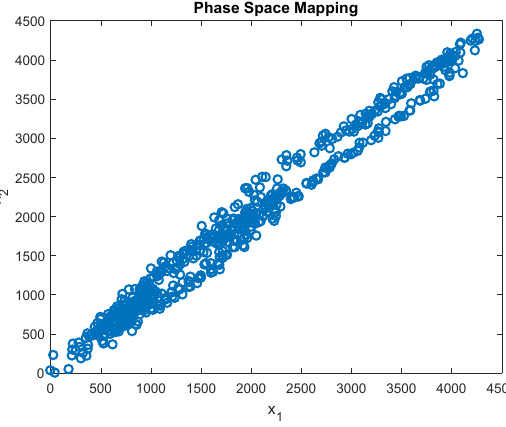
Fig. 5. A phase space mapping for unsuitable lung